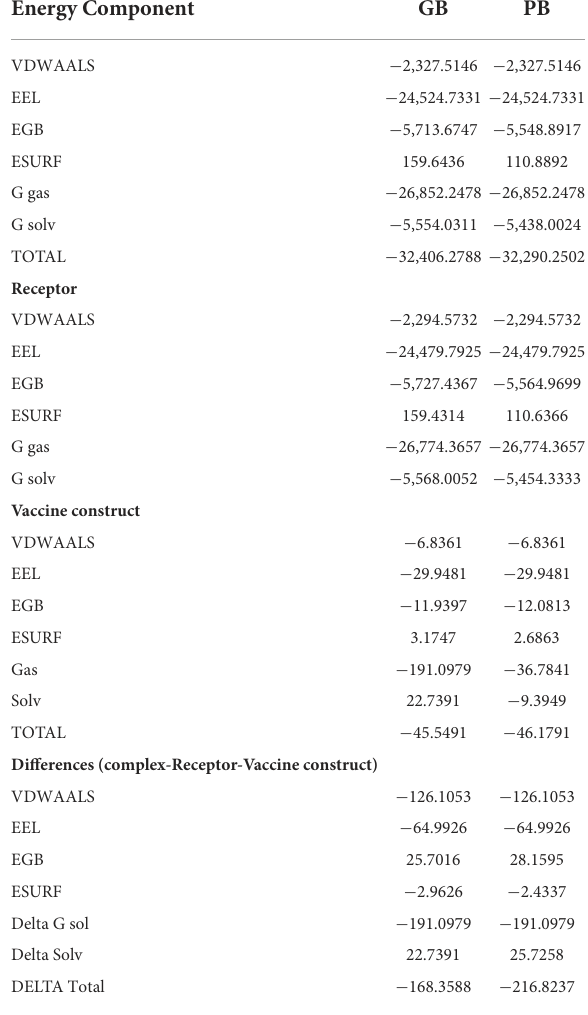
TABLE 5 Binding free energies calculated for vaccine-TLR-5